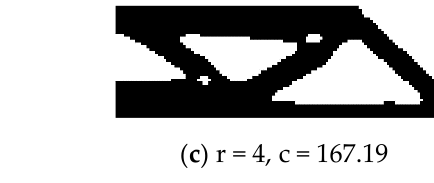
( c ) r = 4, c = 178.45 Figure 12. Optimization results of the SIMP method. According to the optimization results, the objective function obtained by the SIMP- GA method is smaller and closer to the global optimal value. Simultaneously, because SIMP-GA does not directly update the design variables, the design variables are decoded by the chromosome into discrete 0 and 1 values, so there are no intermediate density ele- ments in the optimized result, unlike if the SIMP method was used alone. In the SIMP method, the geometric complexity of the optimization result can be con- trolled by a suitable filtering radius. The SIMP-GA method also inherits this characteristic. When the filtering radius is relatively small, the geometry obtained by SIMP-GA is more complex, but it is simpler than the SIMP method. When the filtering radius is appropri- ately increased, the results obtained by the SIMP-GA method are similar to those obtained by the SIMP method. As the filtering radius continues to increase, the geometric complex- ity of the optimization results obtained by the SIMP method remains effectively un- changed, but the structural geometry obtained by the SIMP-GA method is further simpli- fied. Simultaneously, the intermediate density elements in the optimization results of the SIMP method also increase. If the filtering radius is too large, the intermediate density elements will fill the design area, making the optimization results unreliable. However, with the increase of the filtering radius, SIMP-GA can always obtain simpler geometric complexity results, as show in Figure 13. ( a ) SIMP-GA ( b ) SIMP Figure 13. Optimization result when r = 8.